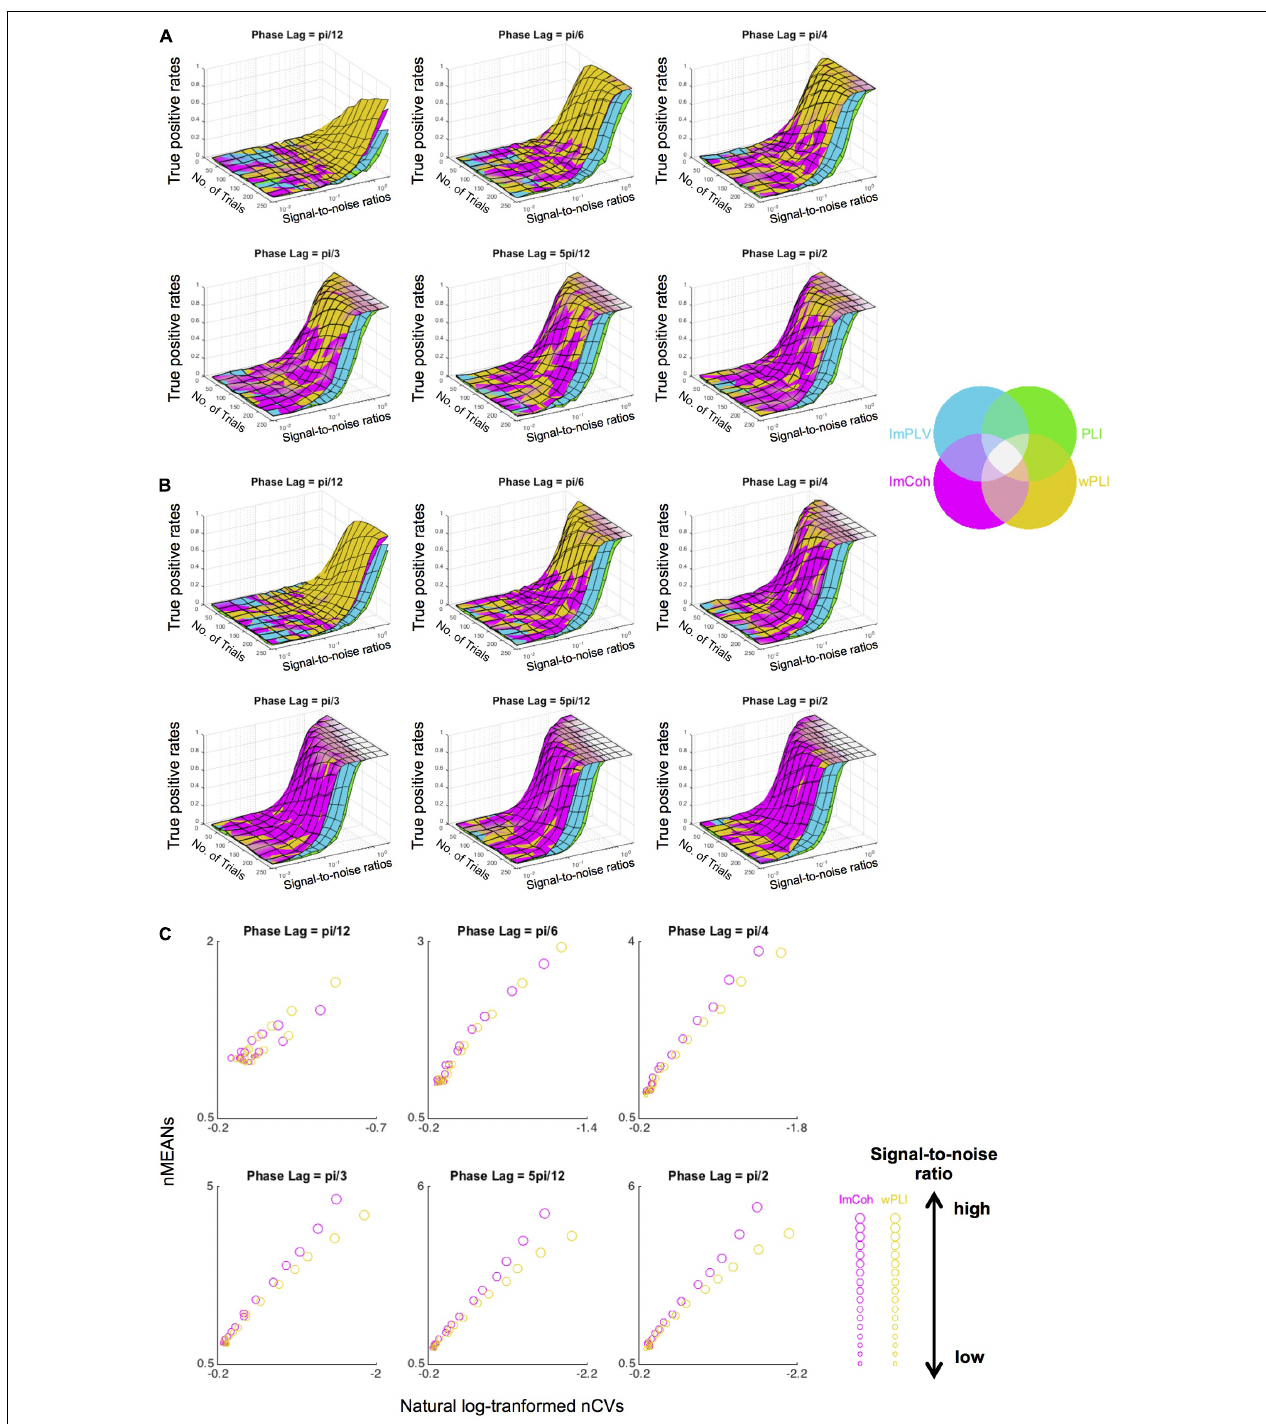
FIGURE 7 | Results of the data simulation of periodograms. (A,B) Surface plots of the true positive rates against numbers of trials and signal-to-noise ratios (SNRs) at each angle in the single-pair simulation (A) and multiple-pair simulation (B) . Surfaces of the plots of each functional connectivity (FC) measure colored with the corresponding color in the color map are overlaid as layers so that the measure with the greatest rate is identified in the uppermost layer. Overall, ImCoh and wPLI show higher rates in most situations. ImCoh tends to have higher rates in the multiple-pair simulation or at larger phase lags, whereas wPLI tends to have higher rates in the single-pair simulation or at smaller phase lags. (C) Dot plots of the means against the coefficient of variances of the normalized FCs in the descriptive statistics analysis for the simulated data. The sizes of dots change depending on the SNRs (getting larger as the SNRs become higher). Note that values increase from right to left in the x-axis of all plots. nMEANs, means of normalized FCs; nCVs, coefficients of variance of normalized FCs.